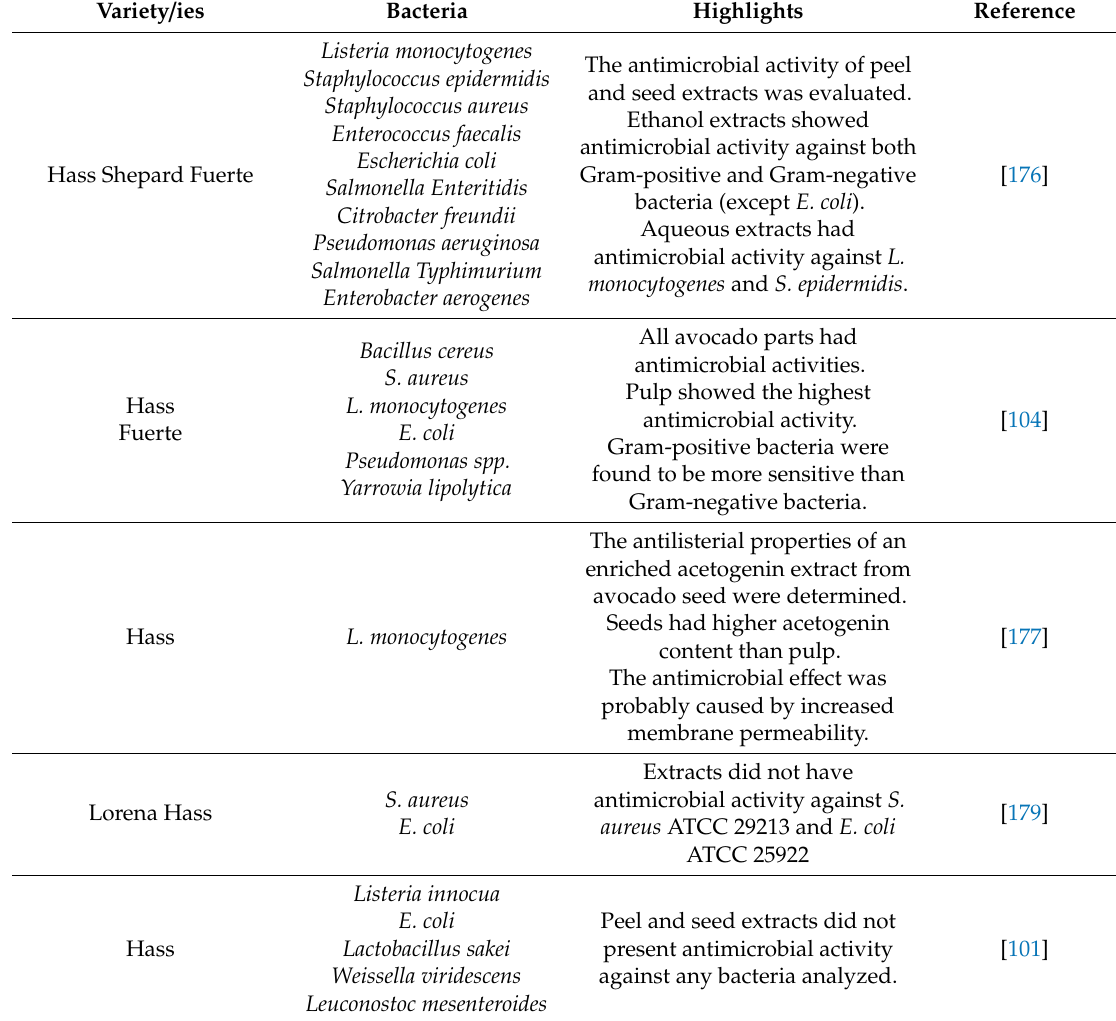
Table 6. Summary of studies that have been conducted that investigated the antimicrobial activity of Persea americana